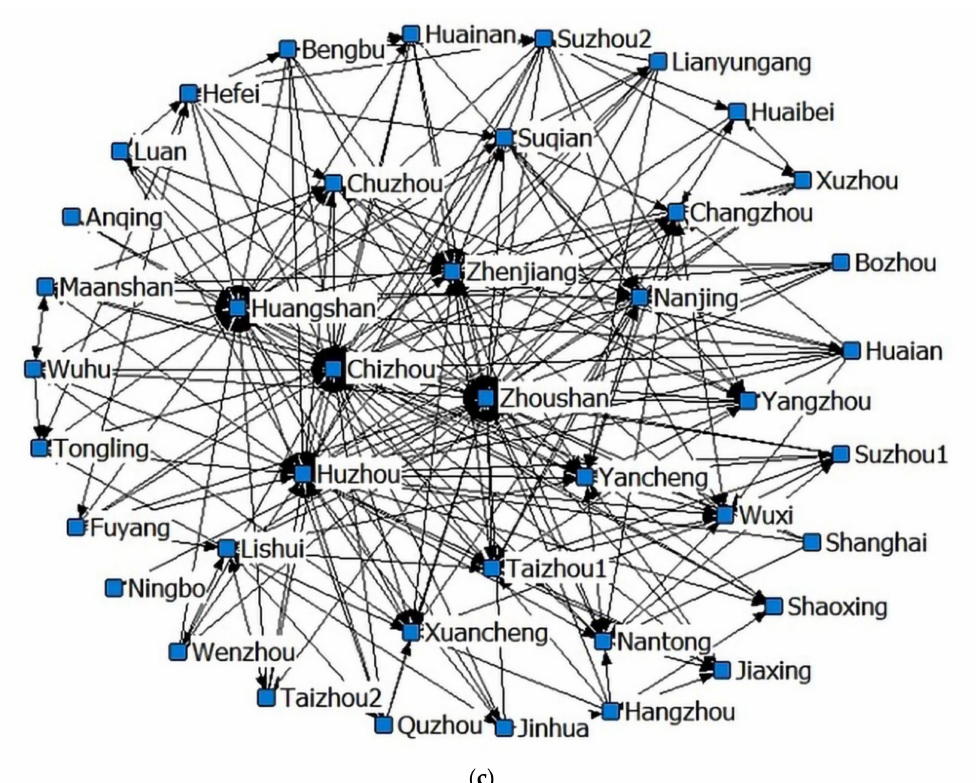
Figure 4. Spatial association network of tourism eco-efficiency in 2008 ( a ), 2013 ( b ), 2017 ( c ).